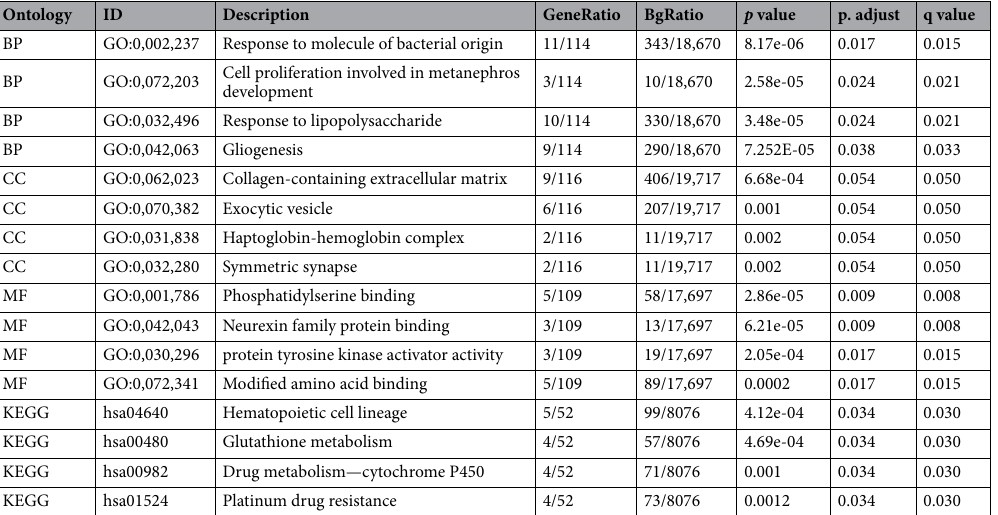
Table 1. Significant enriched GO terms and KEGG pathways of